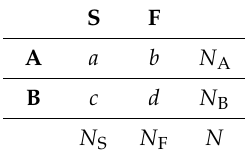
Table 3. Chi-squared test with Yates correction.